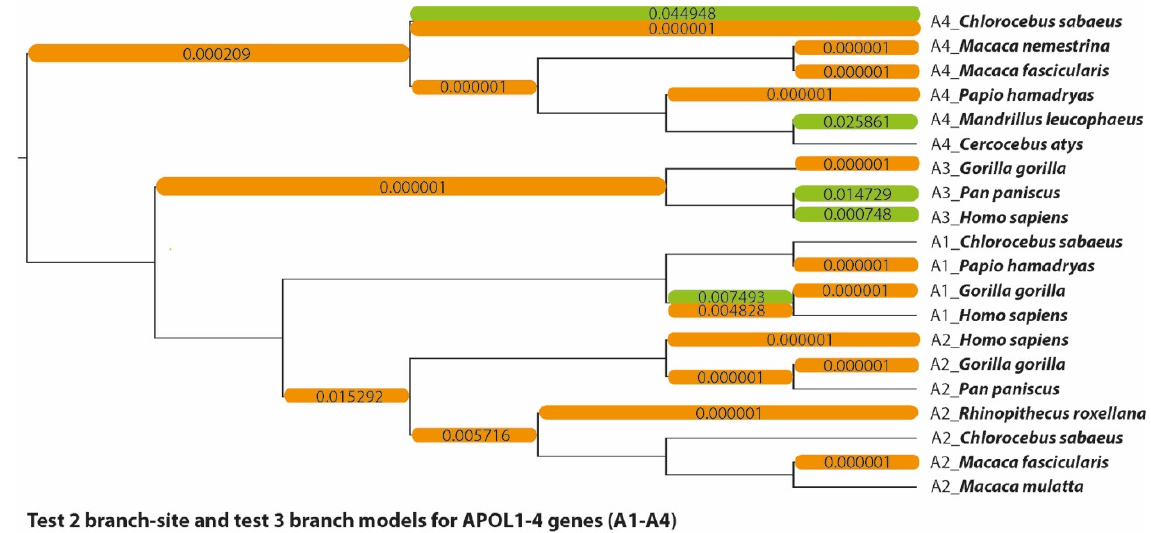
Figure 7. Phylogenetic tree of the APOL1–4 dataset. Branches significantly likely to be under posi- tive selection according to the branch-site models (orange) and branch models (green) (corresponding to Figure 2) are labelled with the p -values inferred by their respective model comparisons. This includes branches with significant LRT results in the branch-site model but without sites under positive selection.